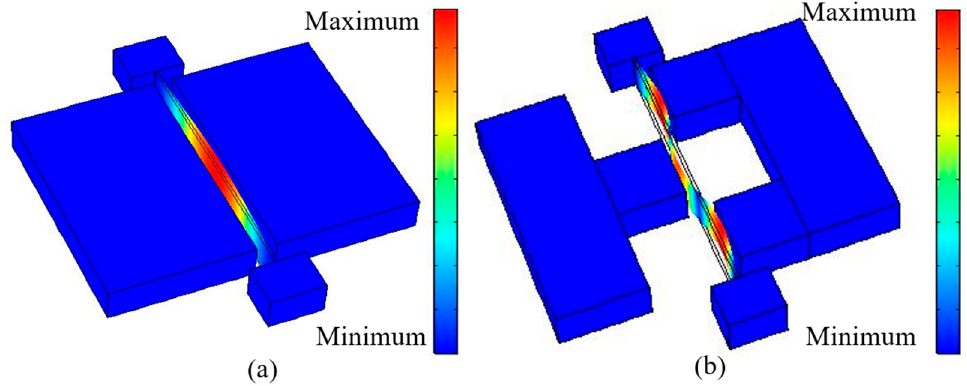
Figure 2. Finite element method (FEM) simulation. ( a ) First mode vibration; ( b ) third mode vibration. Table 1. Summary of parameters of the first, second, third, and fourth mode capacitive resonators. Resonator Structures Vibration Modes